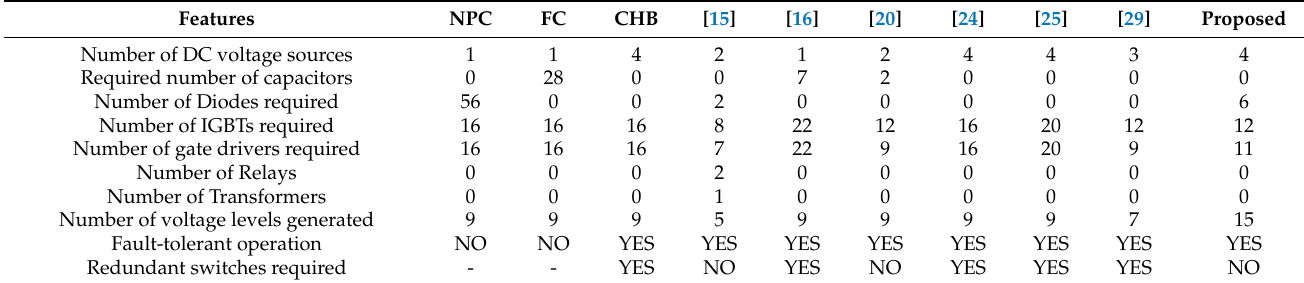
Table 4. Comparative features.